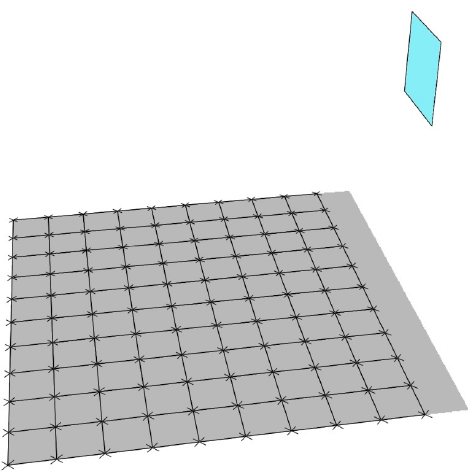
Figure 8. An example of a rectangle 2 m wide by 2 m high, and whose base lies 5 m above the ground. (We assume for convenience that the horizontal surface is a square of 10 × 10 m).